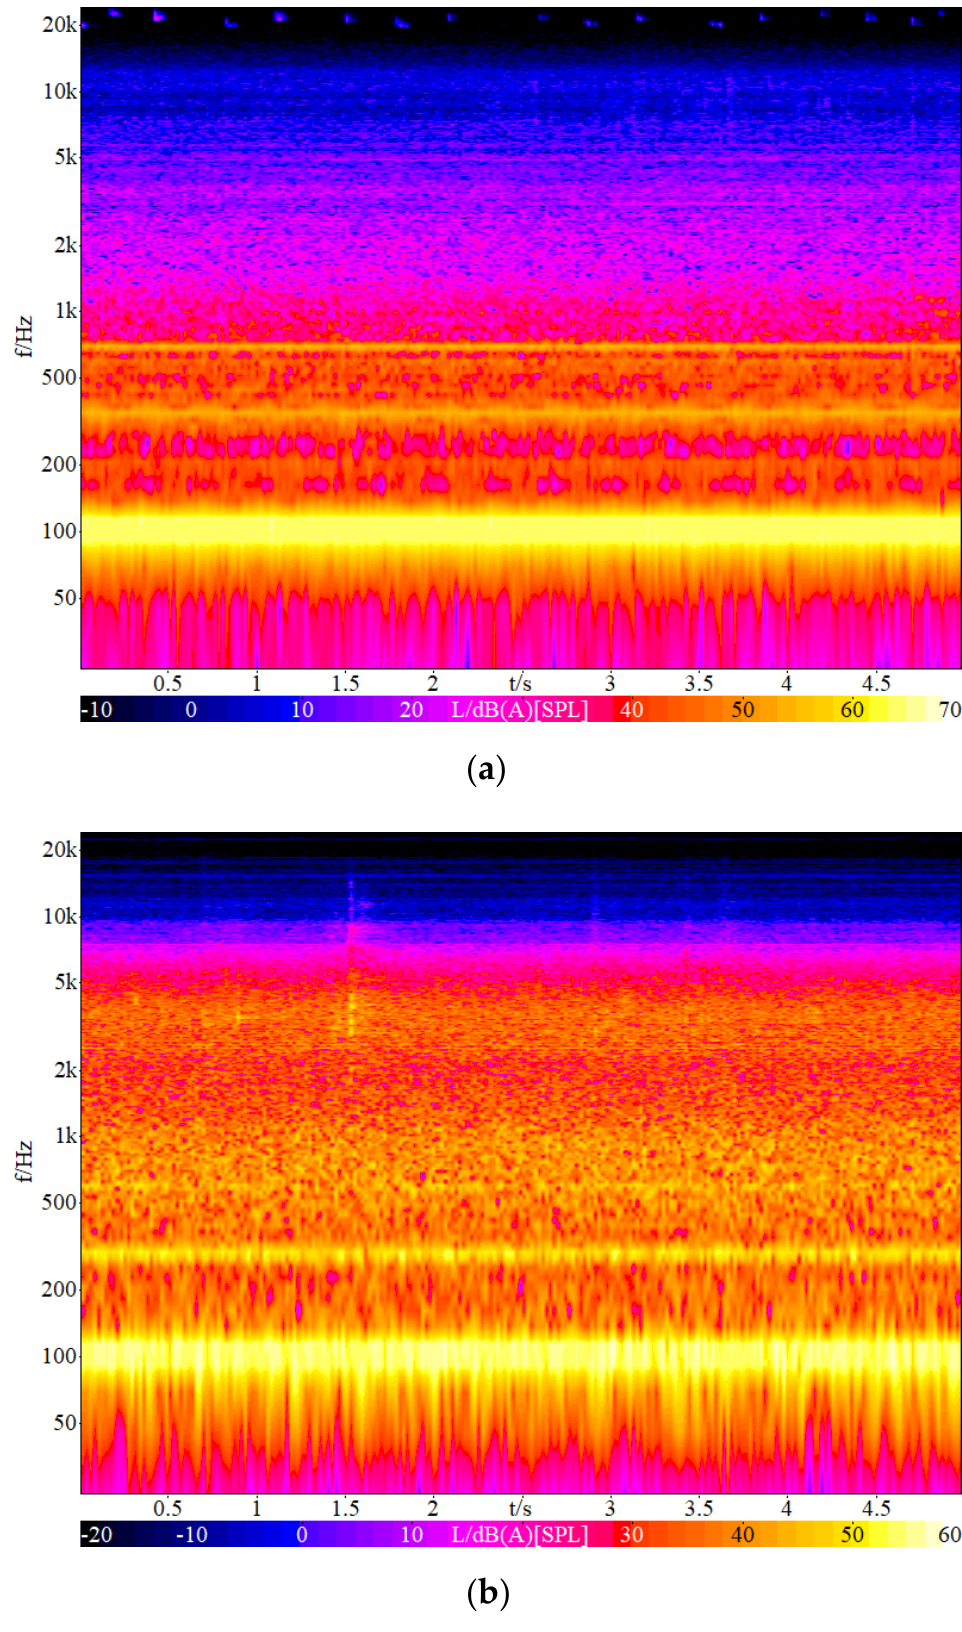
Figure 2. Time-frequency signal of two typical noise samples ( a ) 500 kV substation noise ( b ) 1000 kV substation noise.